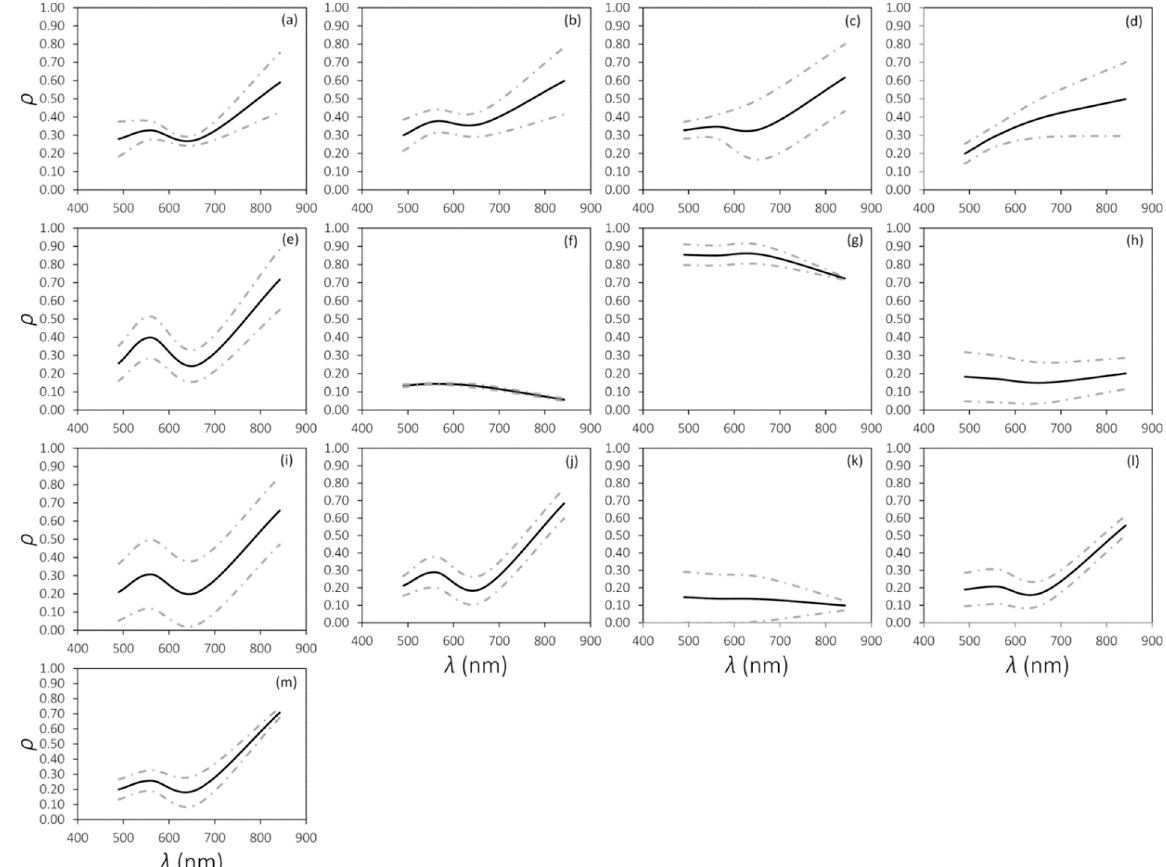
Figure 7. ROIs’ spectral signatures. Bold line represents the mean value; dotted lines are mean value ± 1 standard deviation. ( a ) Dense Forest-1; ( b ) Sparse Forest-111; ( c ) Open Forest-2; ( d ) Bare Soil/Urban-3; ( e ) Grassland and lower vegetation-4; ( f ) Water-5; ( g ) Clouds-6; ( h ) Cloud Shadows-7; ( i ) Lower vegetation with strong vigour-8; ( j ) Agronomical field-9; ( k ) Wetlands and burned areas-10; ( l ) Fragmented croplands-11; ( m ) Croplands-12.